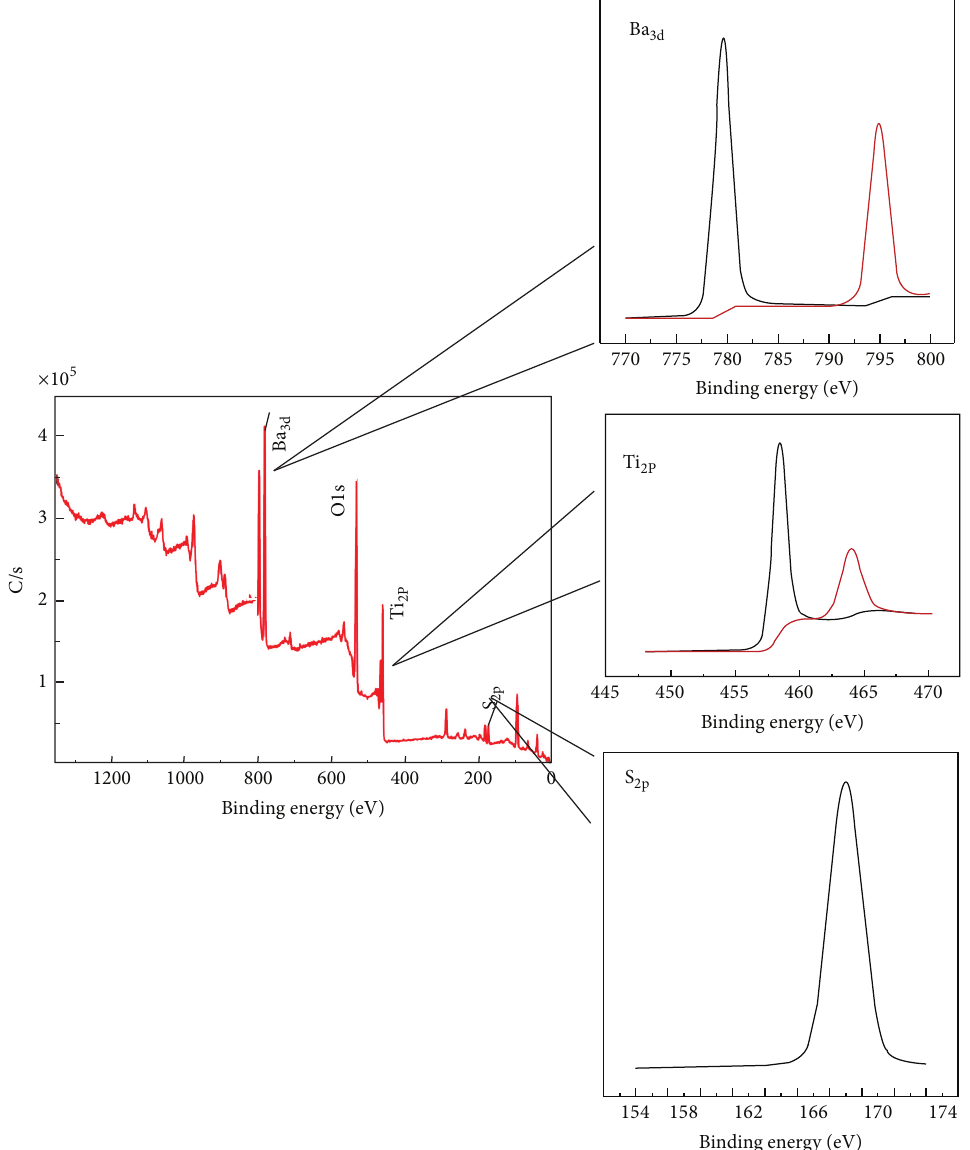
Figure 9: XPS spectrum of all elements of B/TCP and XPS spectrum of Ba, S, and